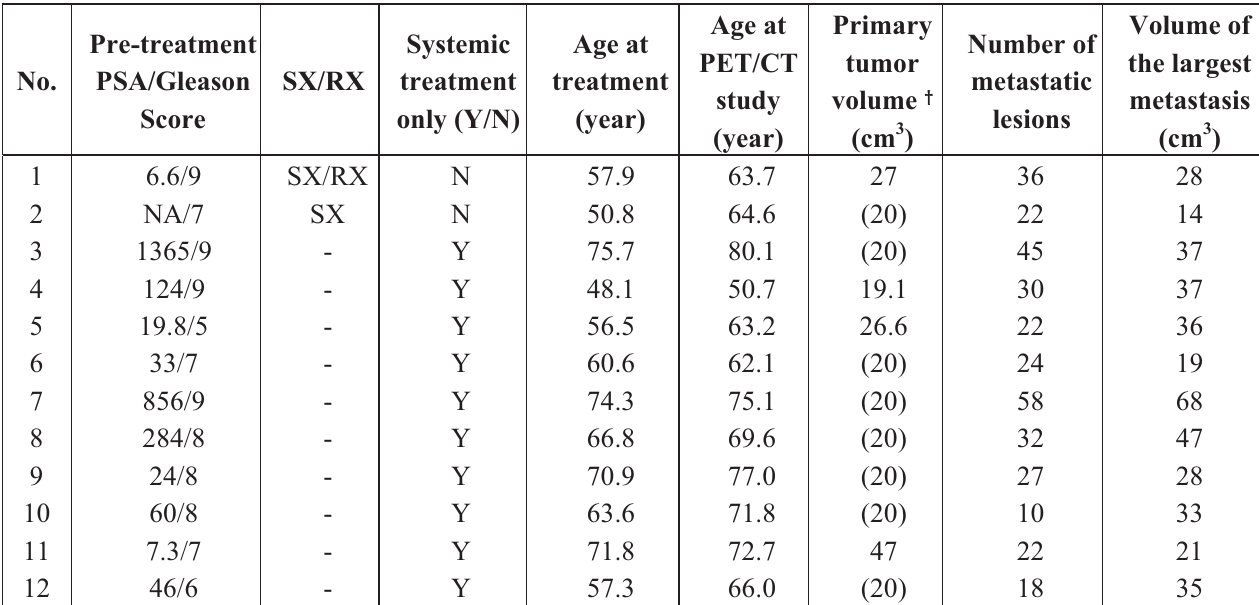
Table 1. Descriptive characteristics of patient cohort (NA=not available; SX=surgery; RX = radiation